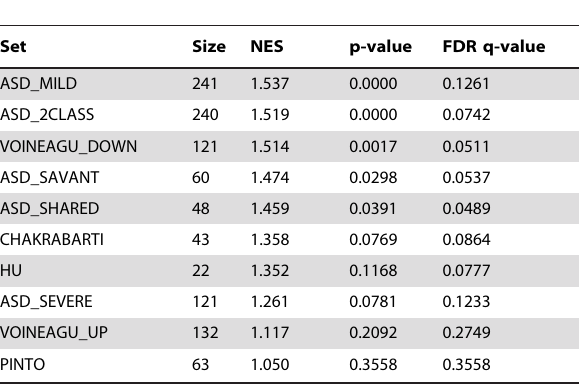
Table 5. Analysis of sets associated with human autism.